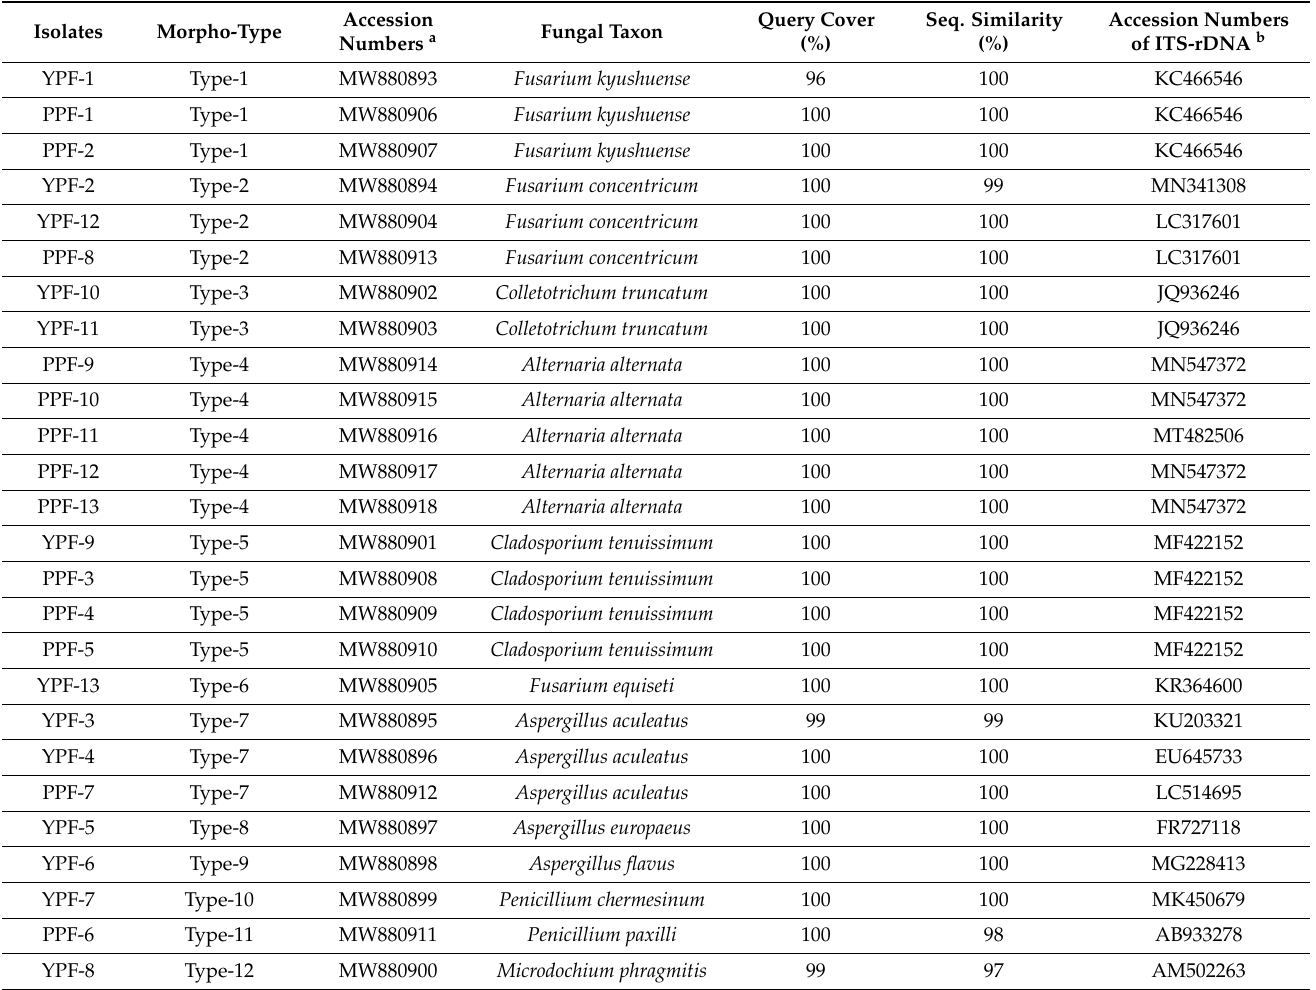
Table 3. Best BLAST matches for fungi based on ITS-rDNA